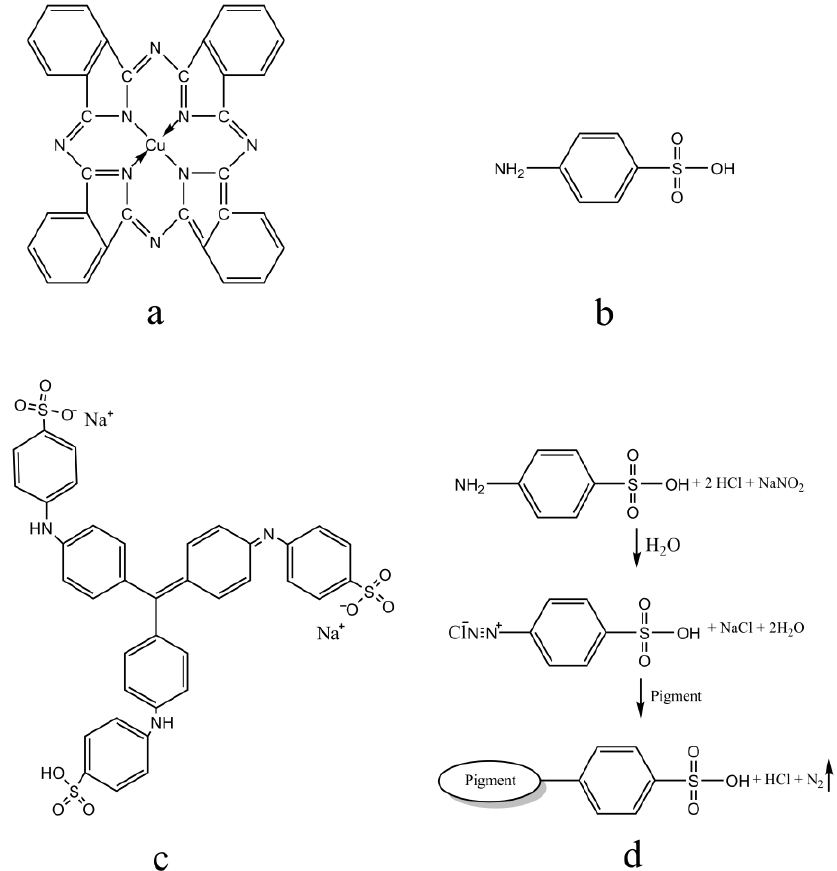
Figure 1. Chemical structure of ( a ) Pigment Blue 15:4; ( b ) p -aminobenzene sulfonic acid; ( c ) Acid Blue 93; and ( d ) reaction scheme.